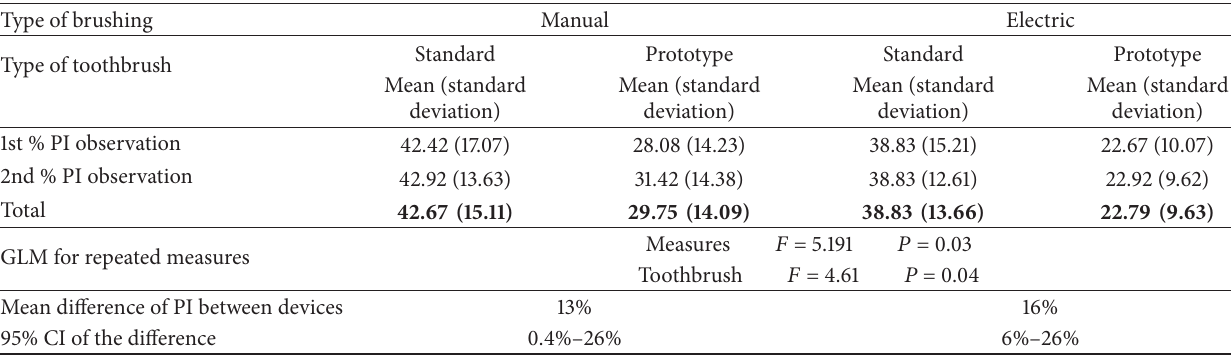
Table 3: Comparison of PI between prototype and toothbrush, on the 12 casts with anomalies ( % PI data ) . Type of